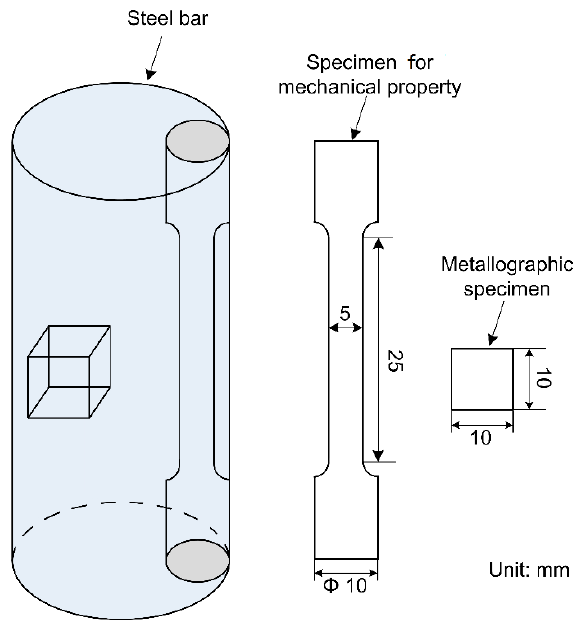
Figure 1. Specimen geometries and their taken positions.